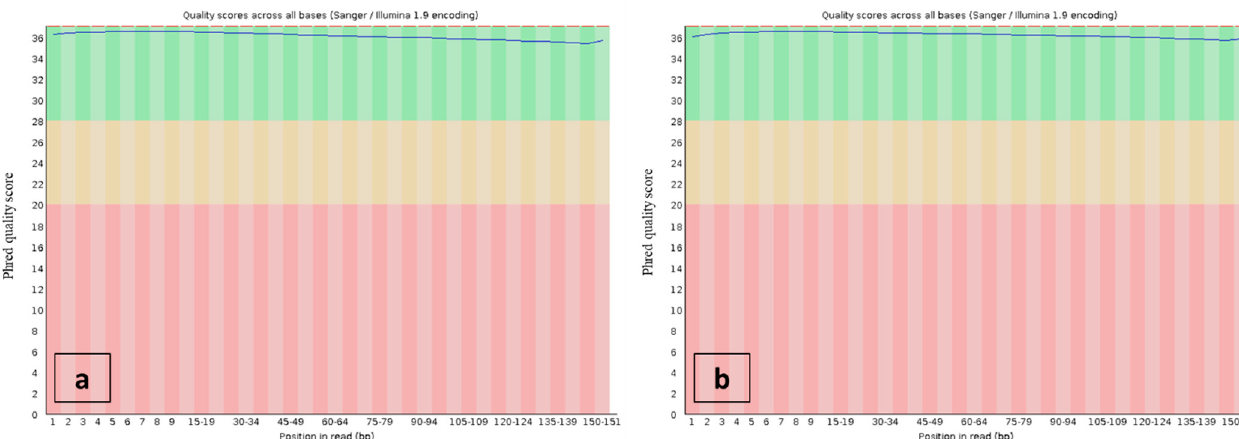
Figure 5. The plot shows the frequency distribution of the contaminating taxa for ( a ) Reseda lutea and ( b ) Reseda pentagyna .